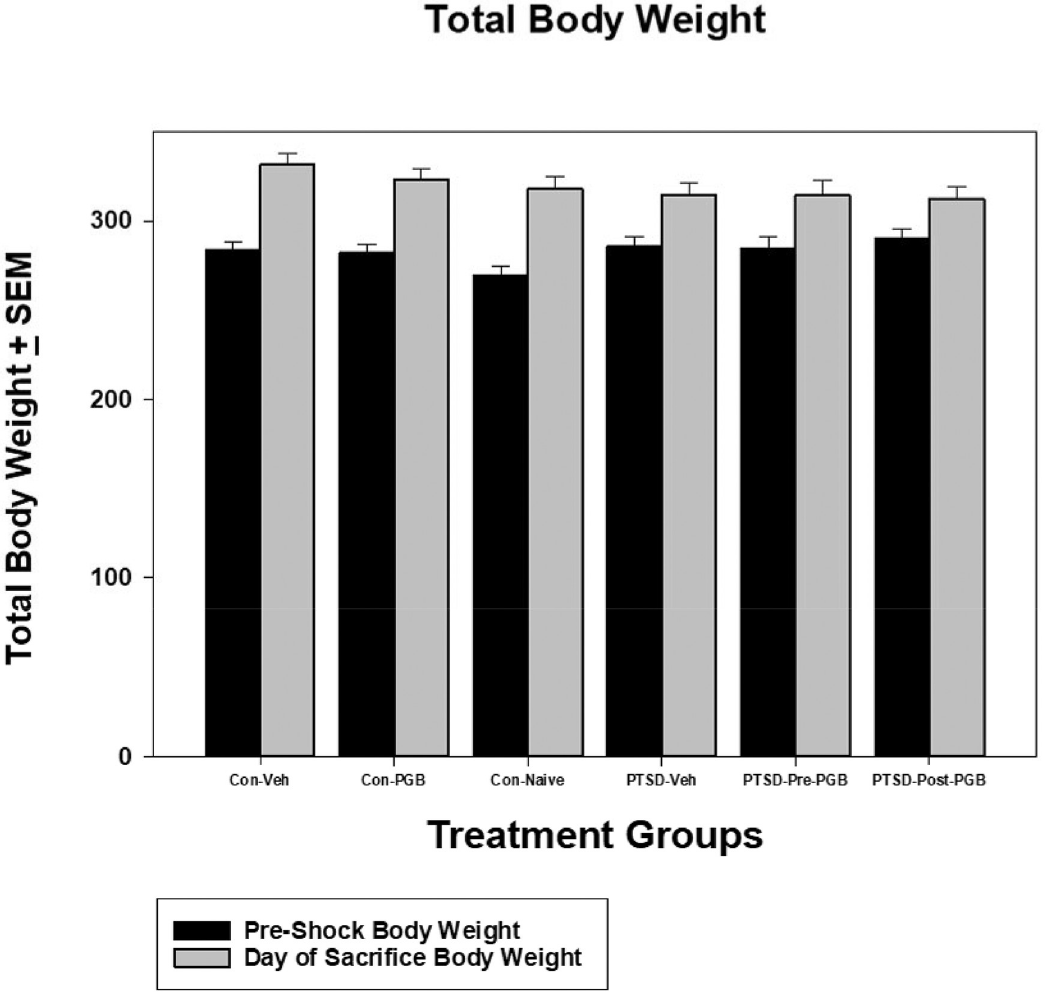
Fig 1. ANCOVA for total body weight. Each of the main two groups (Stressed and Non-stressed) had three subgroups: non- stressed: control vehicle, control PGB, control na ï ve; and stressed: Posttraumatic stress disorder (PTSD) vehicle, PTSD Pre-PGB (prophylactic), PTSD Post-PGB (non-prophylactic). Mean total body weight is reported with the standard error of the mean (SEM).